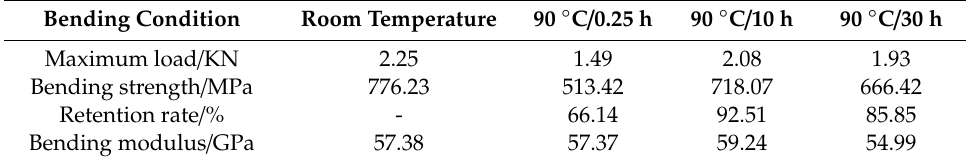
Table 2. Bending properties parameters of 3Dim–5Dir braided composites at 90 ◦ C.